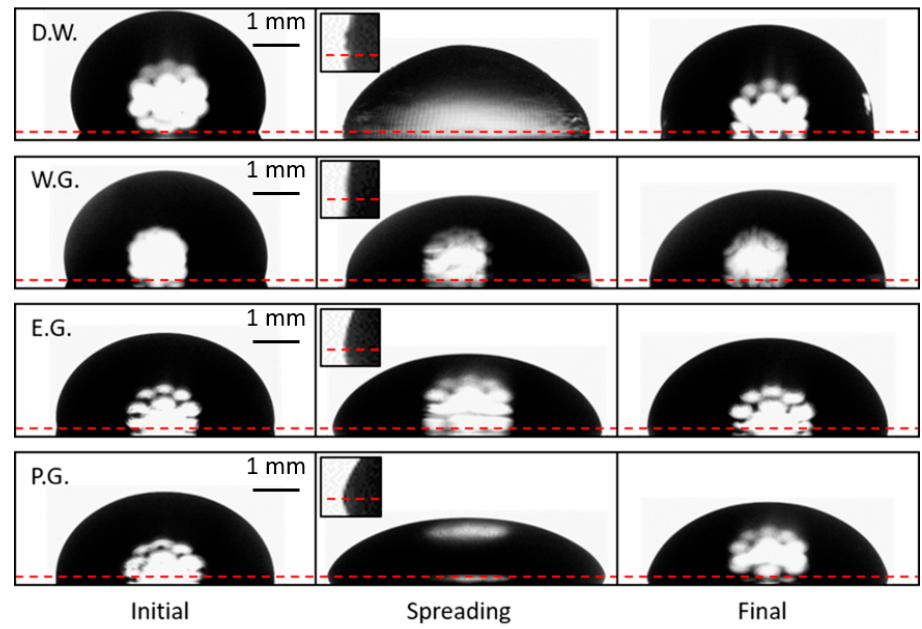
Figure 8. Ultrasonic spreading of deionized water (D.W.), 3:5 water / glycerol (W.G.), ethylene glycol (E.G.), and propylene glycol (P.G.) droplets. Droplets were not vibrated in the initial or final state. The horizontal dashed line is plotted through the triple point at each side of the droplet. The inset images magnify the triple point to clarify the CA oscillations produced by the surface waves if they are resolvable. Small capillary waves were observed on the surface of all liquids tested, however they are most apparent on the surface of deionized water droplets (inset, top row).